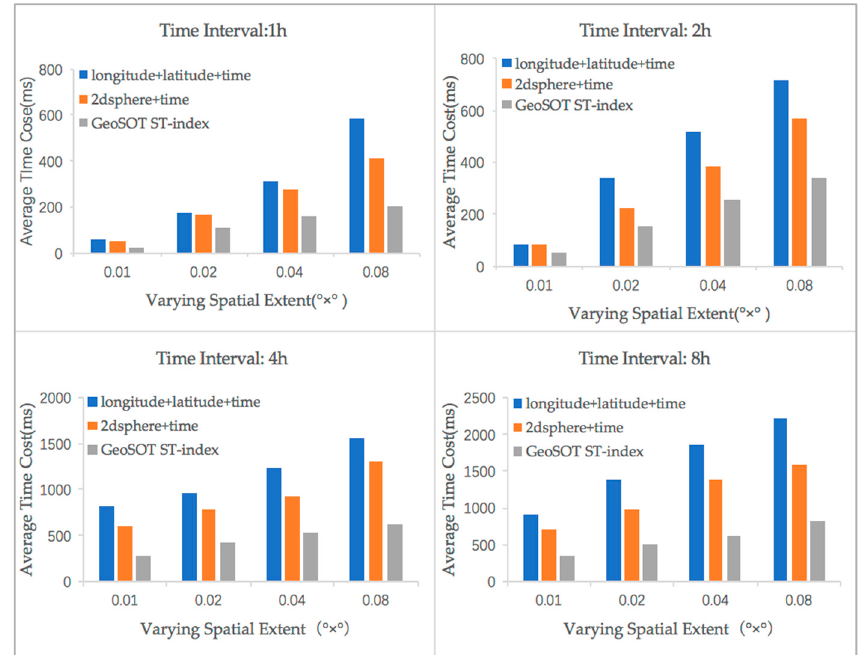
Figure 8. Comparisons of spatiotemporal query efficiency.